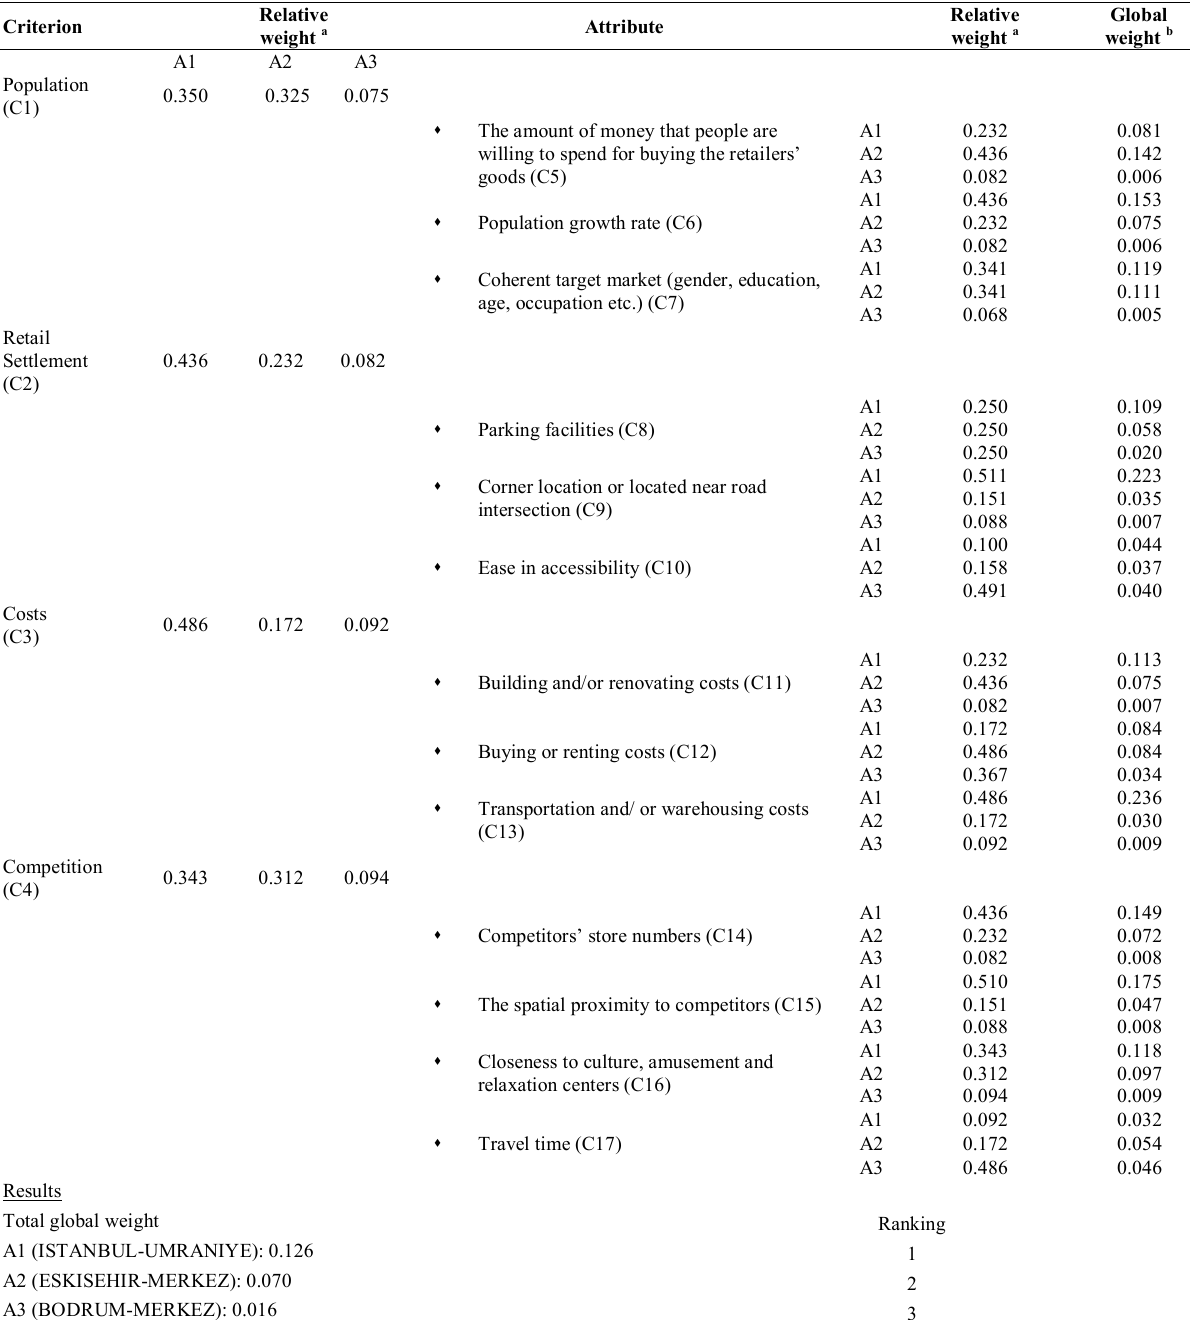
Table 5: Relative and global weights for each alternative in terms of store selection elements